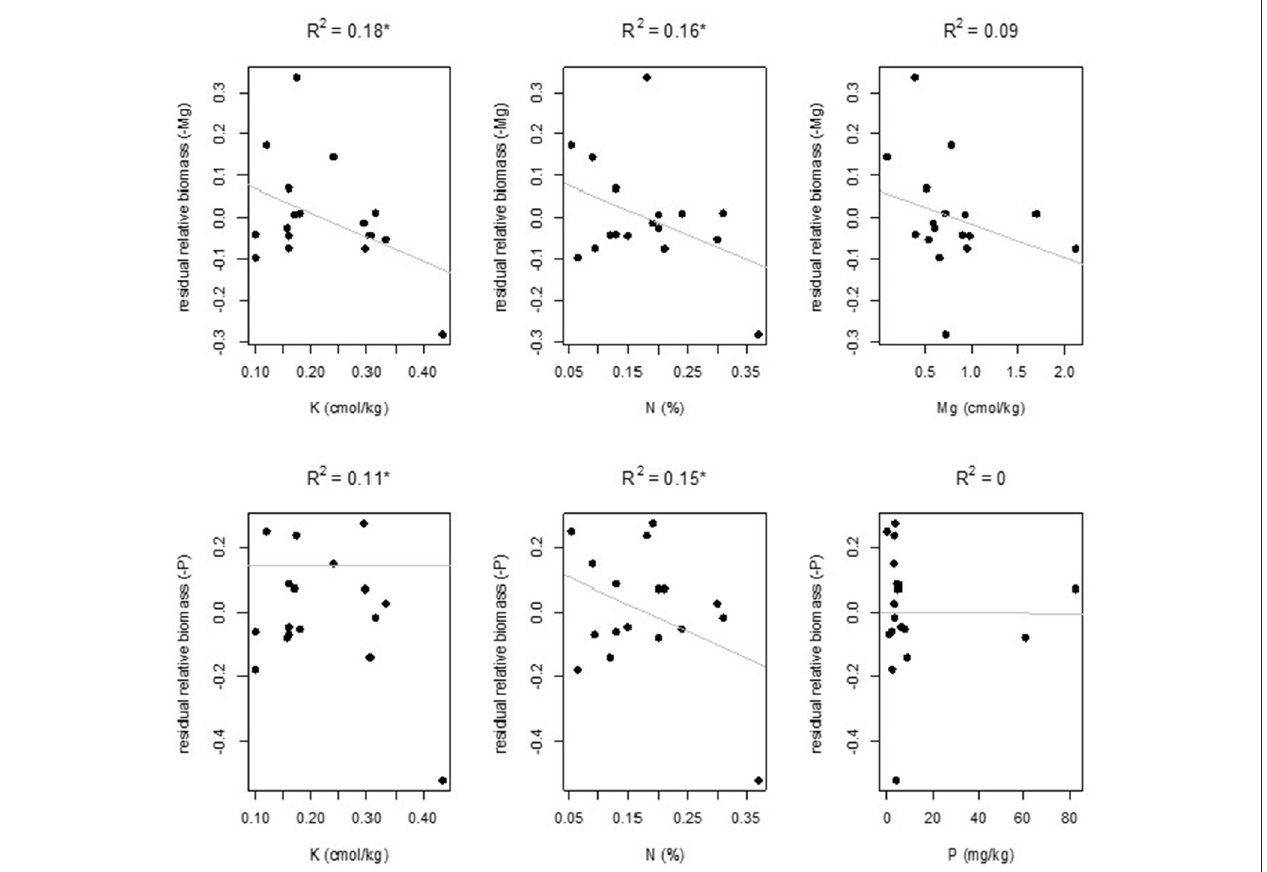
FIGURE 4 | Plots showing the relation between sufficiency difference (upper row) and relative shoot biomass (lower two rows) and soil parameters for the cases where a significant relationship was found (indicated by an asterisk) and for soil content of the missing nutrient. Top row from left to right: growth reduction for -K, against N (%) and K (cmol/kg). Second row left to right: biomass reduction for -Mg, against K (ppm) N (%) and Mg (ppm). Bottom row left to right: biomass reduction for -P, against K (cmol/kg) N (%) and P (mg/kg). Results are shown for the model residuals after correcting for